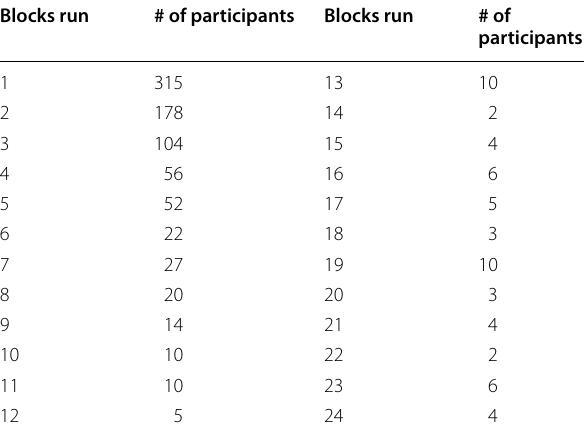
Table 2 Observers divided by reason to participate Compete with others